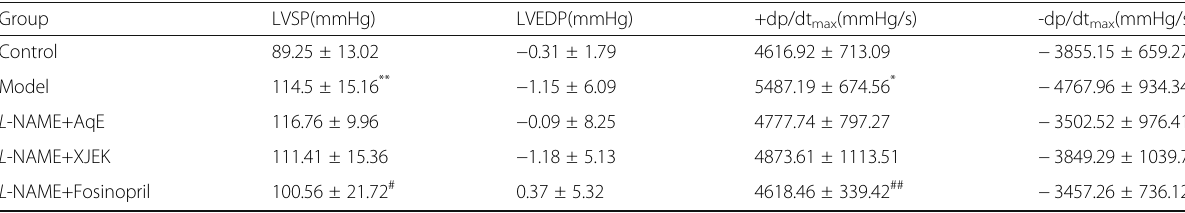
LVSP left ventricular systolic pressure, LVEDP left ventricular end-diastolic pressure, +dp/dt max maximal rate of left ventricular systolic pressure, − dp/dt max maximal rate of left ventricular diastolic pressure. * P <0.05, ** P <0.01 vs control; # P <0.05, ## P <0.01 vs